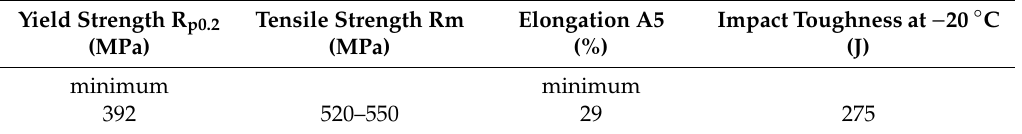
Table 2. Mechanical properties for S355 steel.